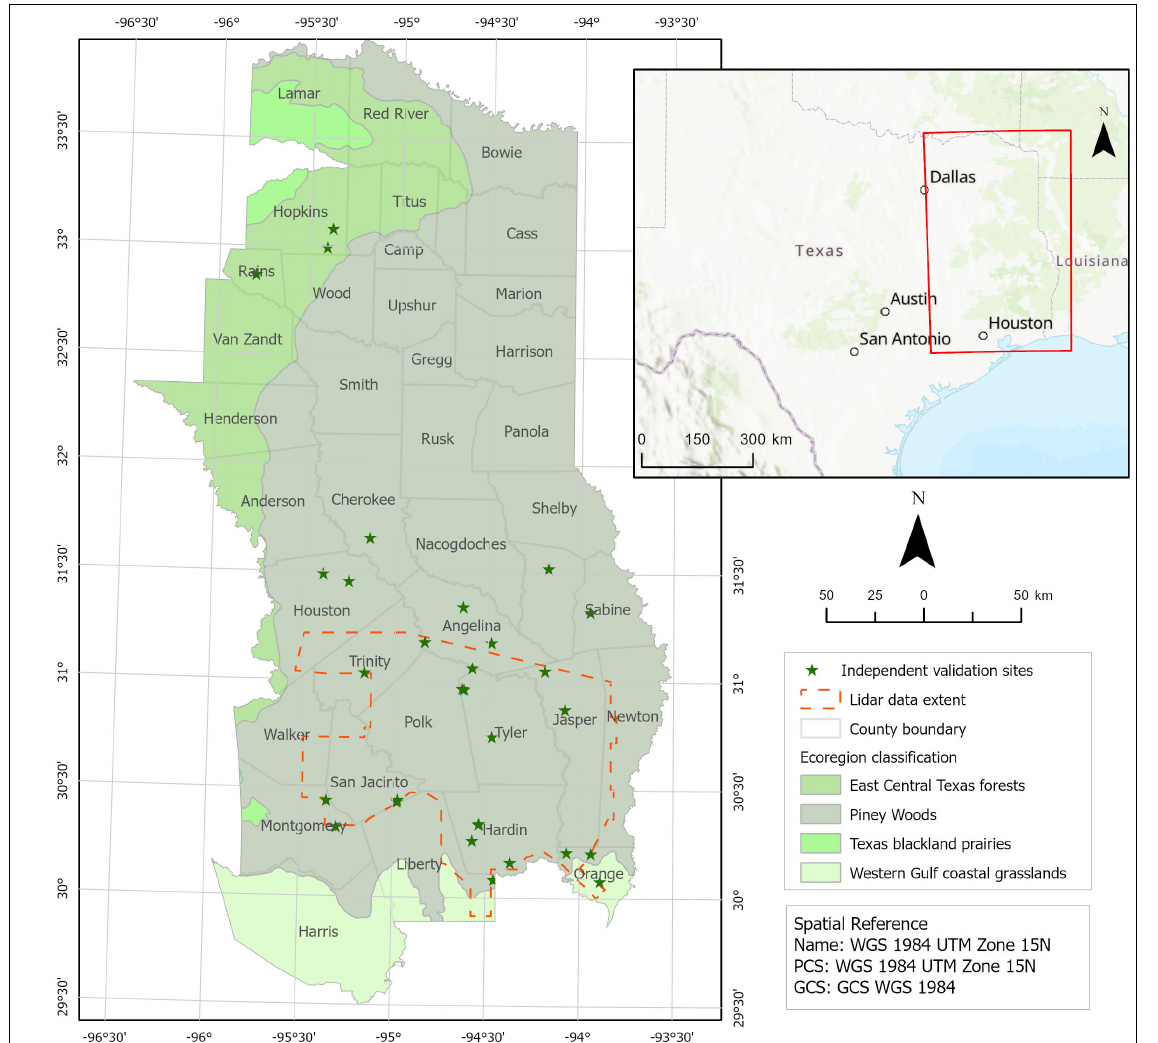
Figure 1. Study area in eastern Texas, USA. Main map shows the study area classified by ecoregion. The ecoregion classification is based on the RESOLVE Ecoregions 2017 map [40]. The red dashed outline in the main map indicates the extent of airborne lidar data collected for this study. Green star symbols show independent validation sites used to evaluate generated stem volume product. The map inset shows the general location (red rectangular outline) of the study site in the Texas–Louisiana–Arkansas region. Topographic base maps show terrain and river network in both maps courtesy of ESRI ArcGIS ® .